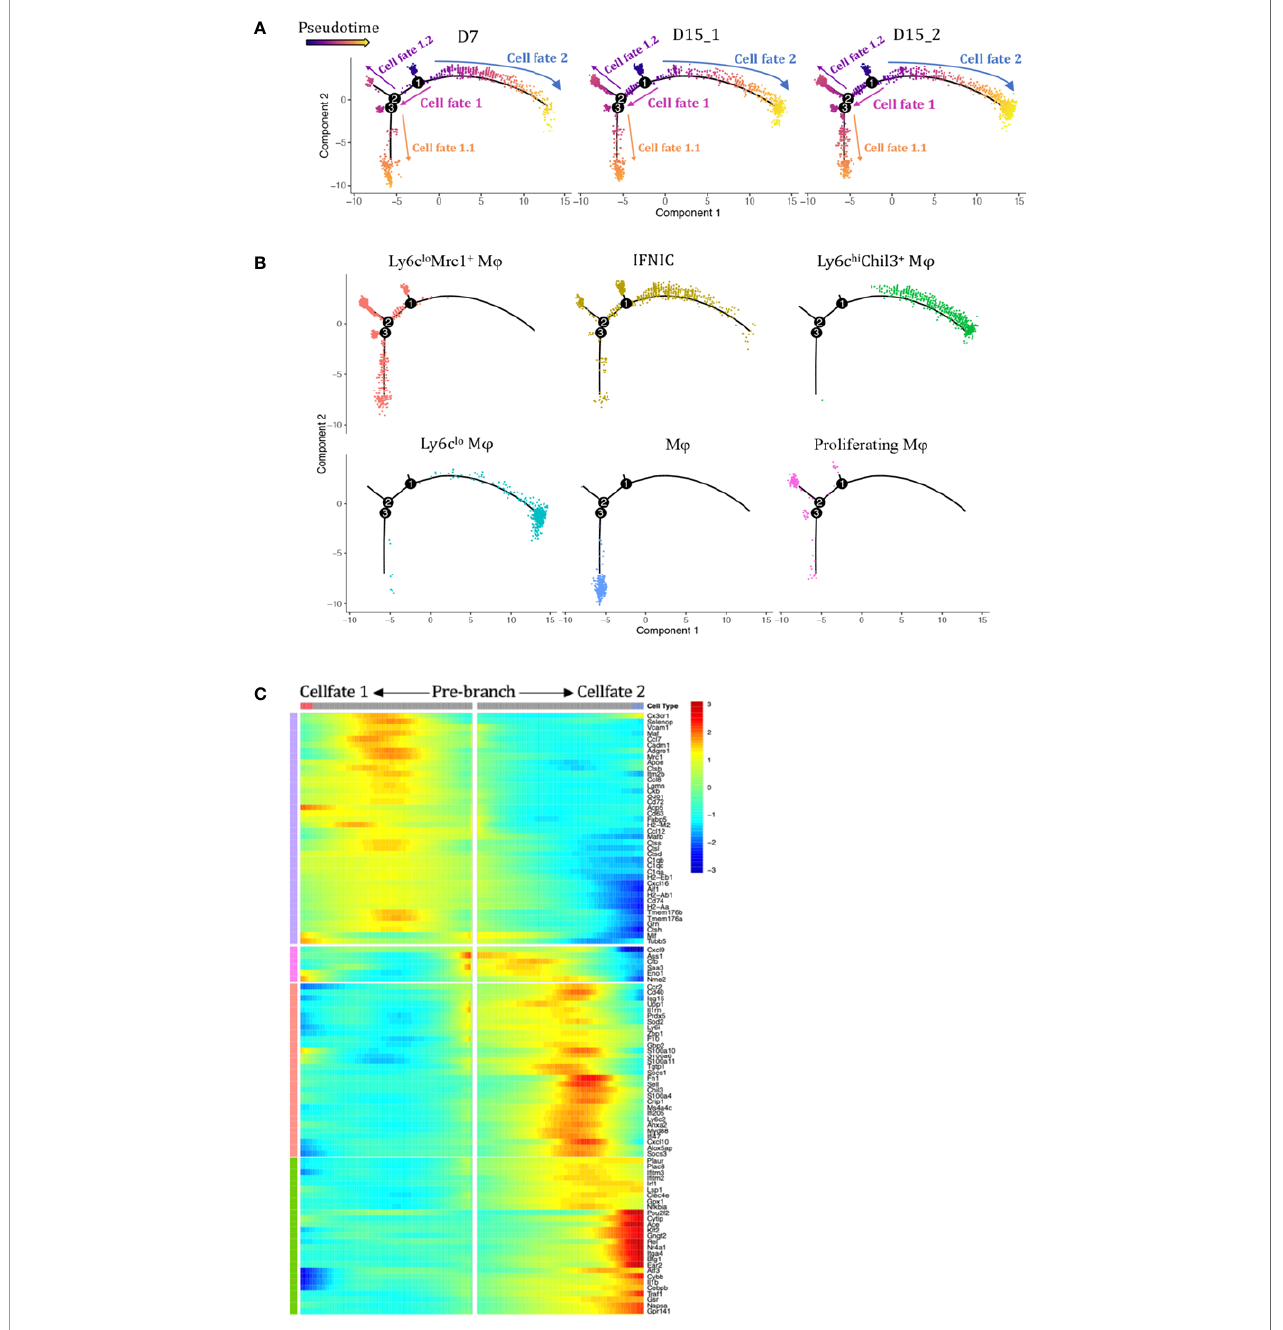
FIGURE 4 | Analysis of macrophage differentiation trajectories in the transplanted kidney. Pseudotime analysis in Monocle split according to (A) rejection types and (B) seurat clusters. Each dot represents a single cell. (C) Heatmap of pseudotime gene expression variation on branches of the pseudotime tree (as indicated in A , only top 106 variable genes are shown). D7, day 7; D15, day 15; M j , macrophage; IFNIC, IFNg induced